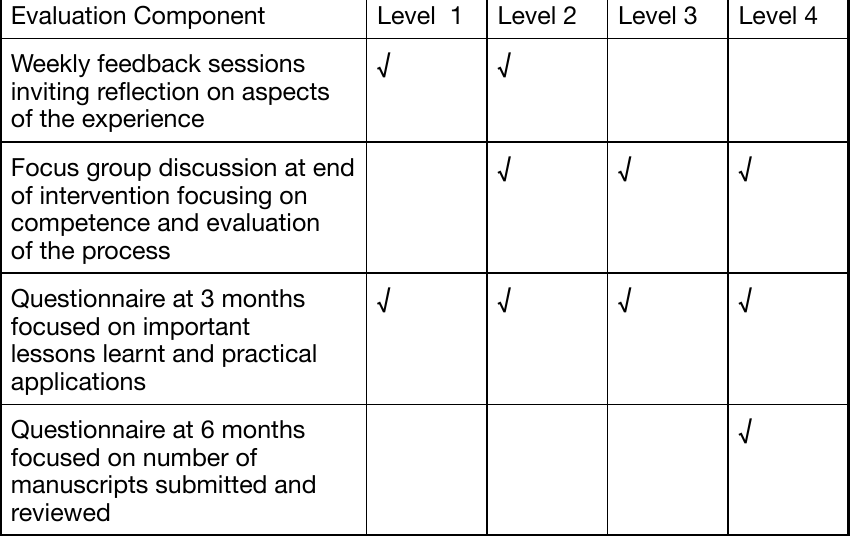
Table 1: evaluation framework for the Writing for Publication workshop Evaluation Component